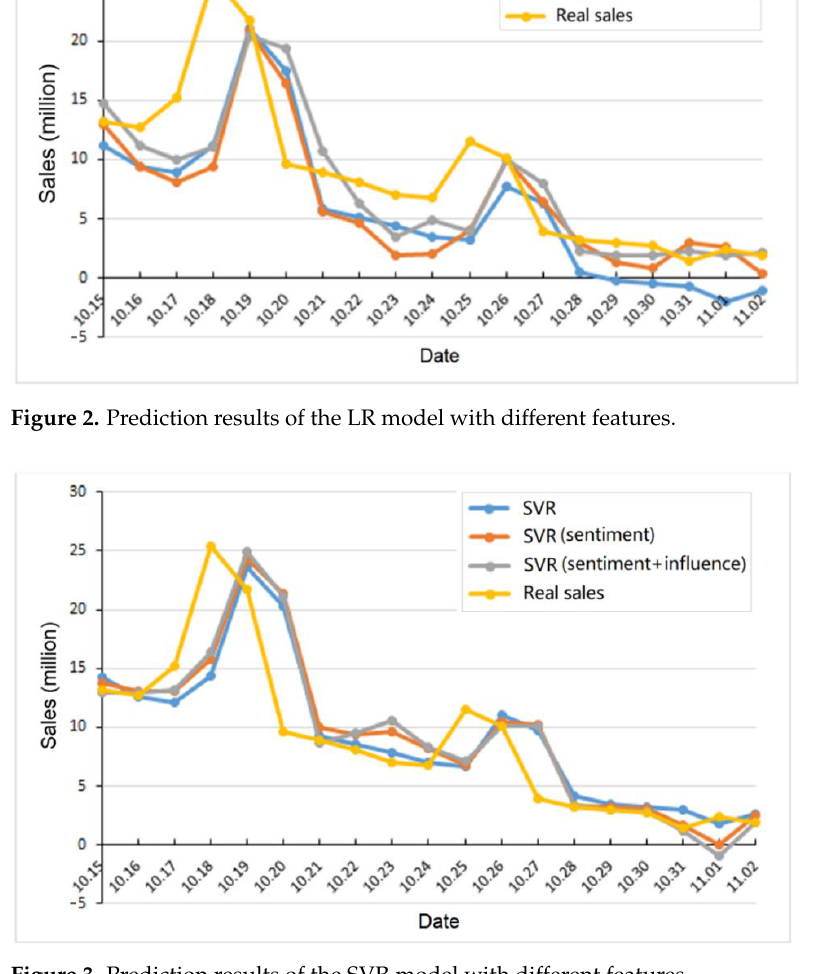
Figure 4. Comparison of the prediction models with real sales. 5. Conclusions and Future Work With the explosive development of microblogs, predicting future information based on microblogs is a recent research focus. In this paper, considering the timely updates and interaction of microblogs, we presented a new framework to use microblogs to predict short-term product sales. The novel idea of the proposed framework is to integrate the sentiment polarity and the microblog influence into a prediction model, such as the LR model and the SVR model. We conducted experiments on a real dataset concerning the early box office prediction, which was crawled from Sina Weibo, the biggest microblogging platform in China. The results demonstrated that the proposed sentiment polarity and influence feature of microblogs play a positive role in improving the